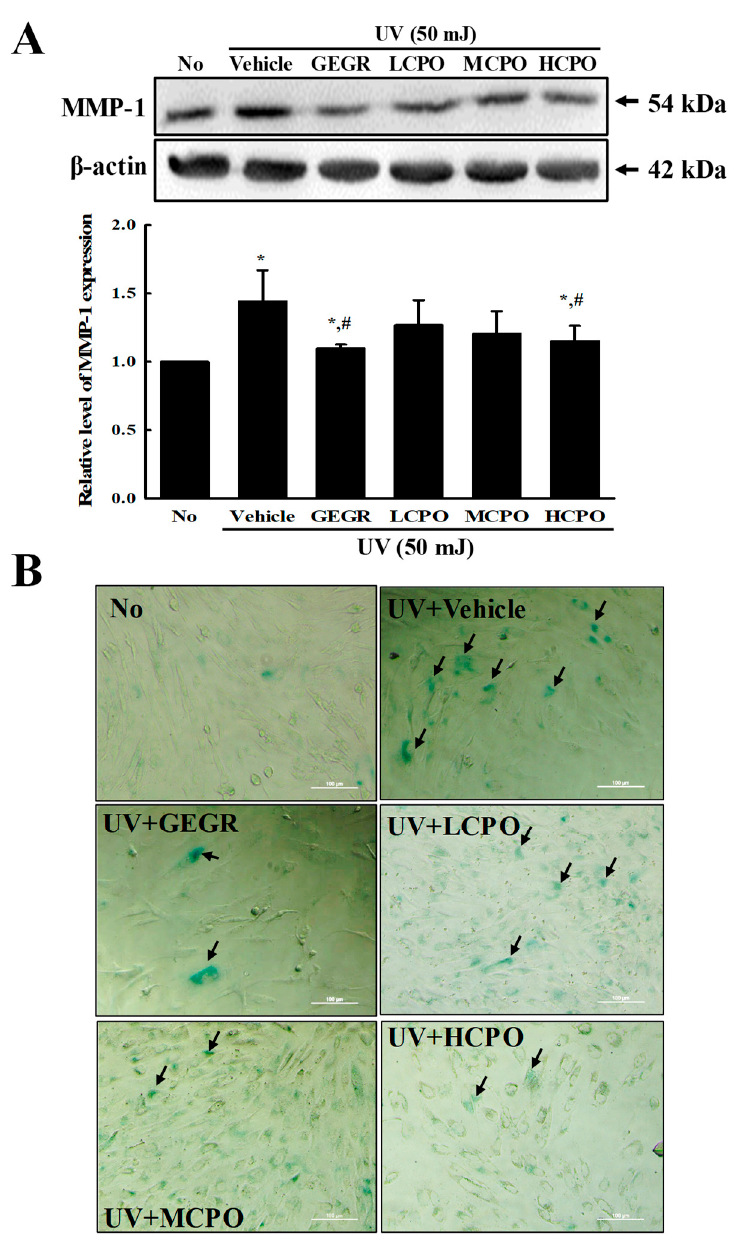
Figure 6. MMP-1 expression and galactosidase staining analyses of UV + CPO treated cells. ( A ) Western blot for MMP-1 protein. The level of MMP-1 and β -actin protein in lysates were determined by Western blotting using HRP-labeled anti-rabbit IgG antibody. Band intensities were measured using an imaging densitometer. The relative levels of MMP-1 protein were calculated versus β -actin protein. Two to three dishes per group were combined for western blotted analysis and samples were assayed in duplicate. ( B ) Galactosidase staining analyses. After incubation with galactosidase staining solution at 37 ◦ C, color intensity in the cells were observed at 400 × magnification under a microscope. Arrows indicated a X-gal stained cell. Two to three dishes per group were combined for western blotted analysis and samples were assayed in duplicate. Data are reported as the means ± SD. * p < 0.05 compared to the No group. # p < 0.05 compared to the UV + Vehicle group. Abbreviations: LCPO, low concentration CPO; MCPO, medium concentration CPO; HCPO, high concentration CPO; GEGR, gallotannin-enriched extract of Galla